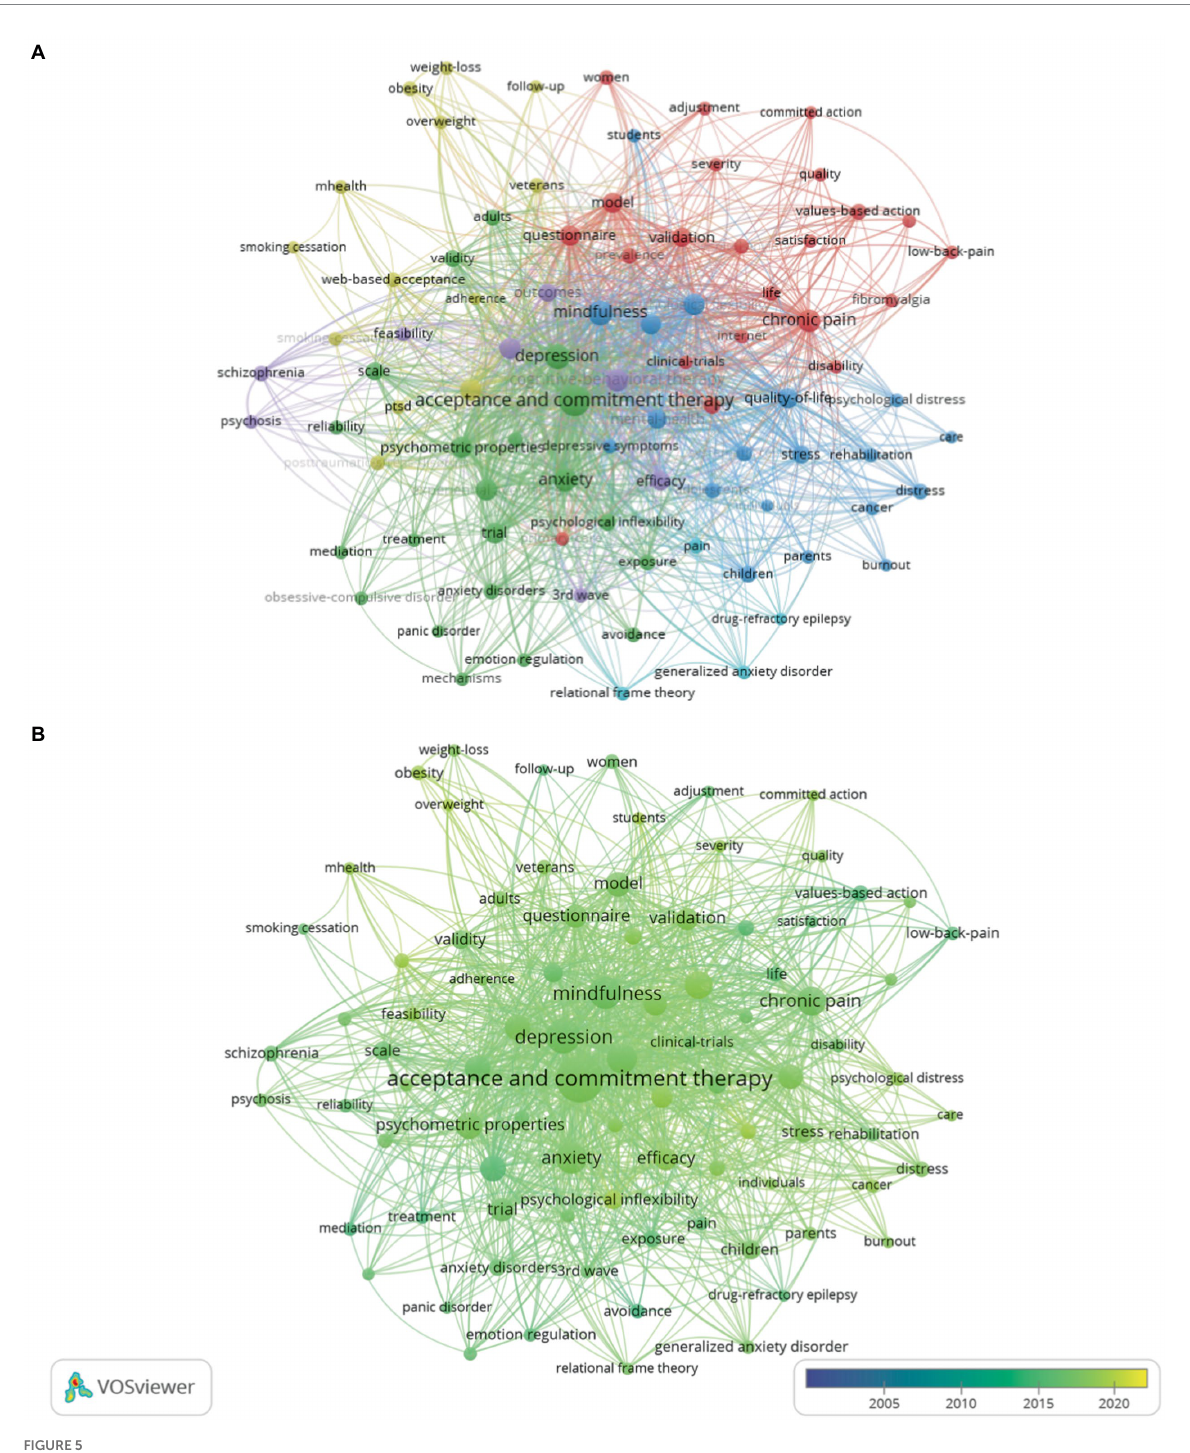
FIGURE 5 (A) The network map of keywords (top 100). (B) The overlay map of keywords (top